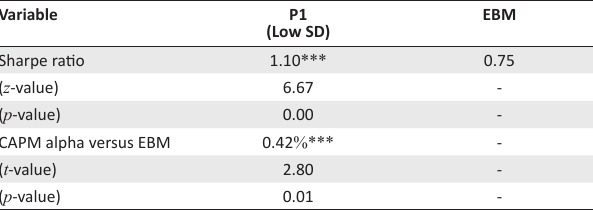
TABLE 7: Risk-adjusted performance of the low-volatility quintile portfolio. Variable